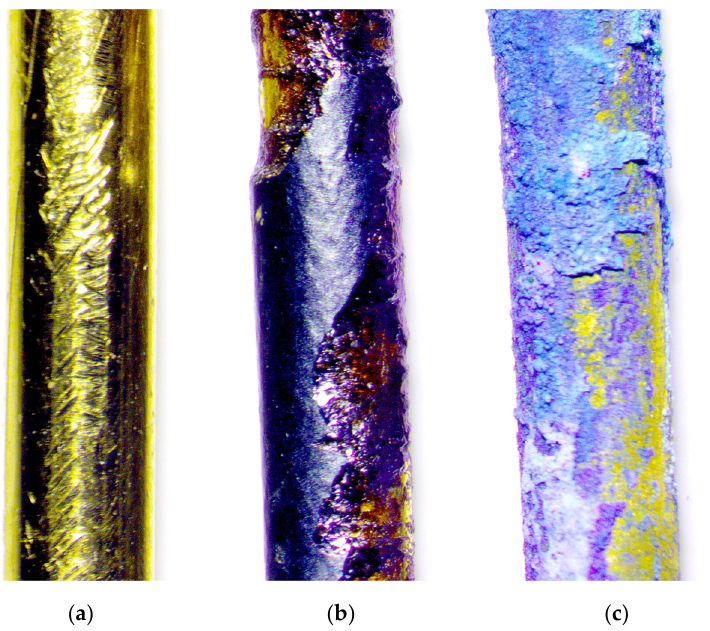
Figure 14. View of conductor surface ( a ) prior to heating, ( b ) after 120 min of heating, and ( c ) after cooling down to 25 °C.